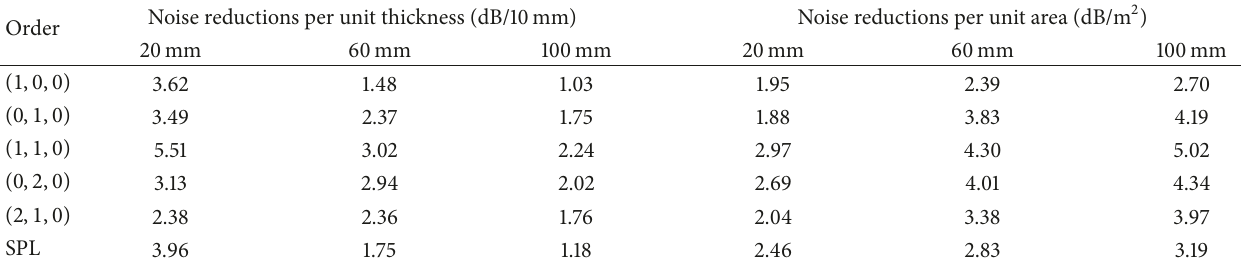
Table 3: Noise reductions as a function of thickness and surface area